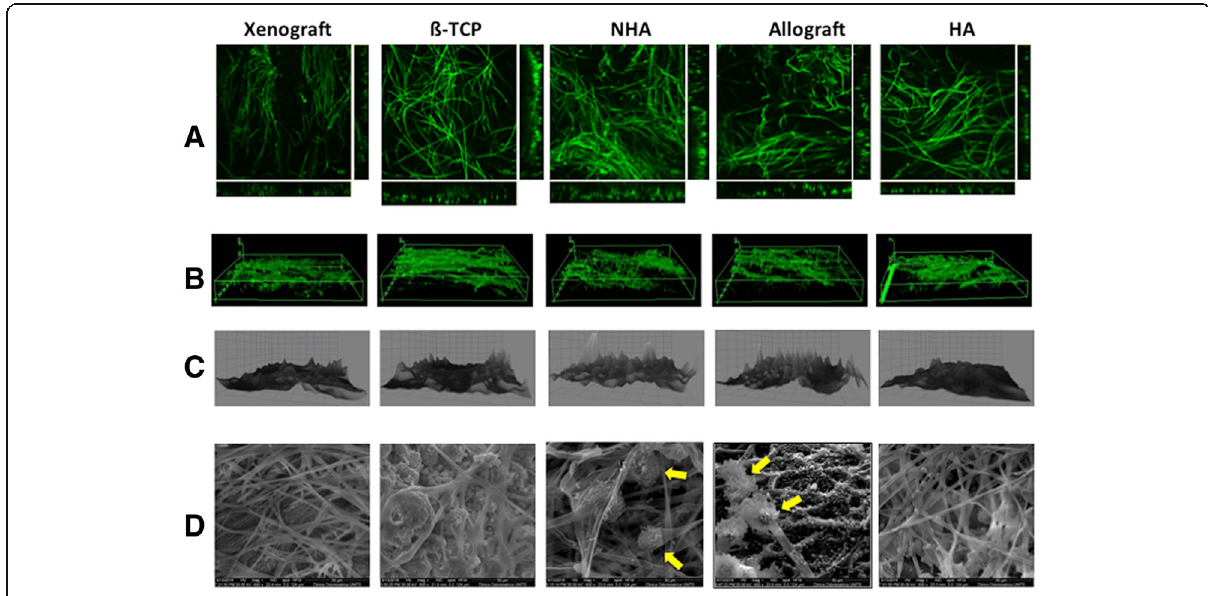
Fig. 1 CLSM and SEM micrographs of the A. fumigatus biofilm on five different bone substitutes. Xenograft: anorganic bovine bone; ß-TCP: ß- tricalcium phosphate; NHA: synthetic nano-hydroxyapatite; Allograft: demineralized bone matrix; HA: synthetic hydroxyapatite. 10 5 conidia/ml inoculated onto the different materials were incubated for 8 h to allow adhesion. After washing the unbound cells, the biofilm was grown in fresh medium for 20 h, washed gently with PBS and analyzed with CLSM ( a , b , c ) and SEM ( d ). a Orthogonal view, showing the mycelium morphology, characterized by highly intertwined hyphae. b 3D volume image, displaying the biofilm pellicle distributed over the surface of the materials. c 3D surface plot, revealing the lower density of the superficial layer of the biofilm formed on NHA and allograft. d × 600 magnification SEM micrographs: conidiophore detected in the biofilm formed on NHA and allograft are indicated by yellow